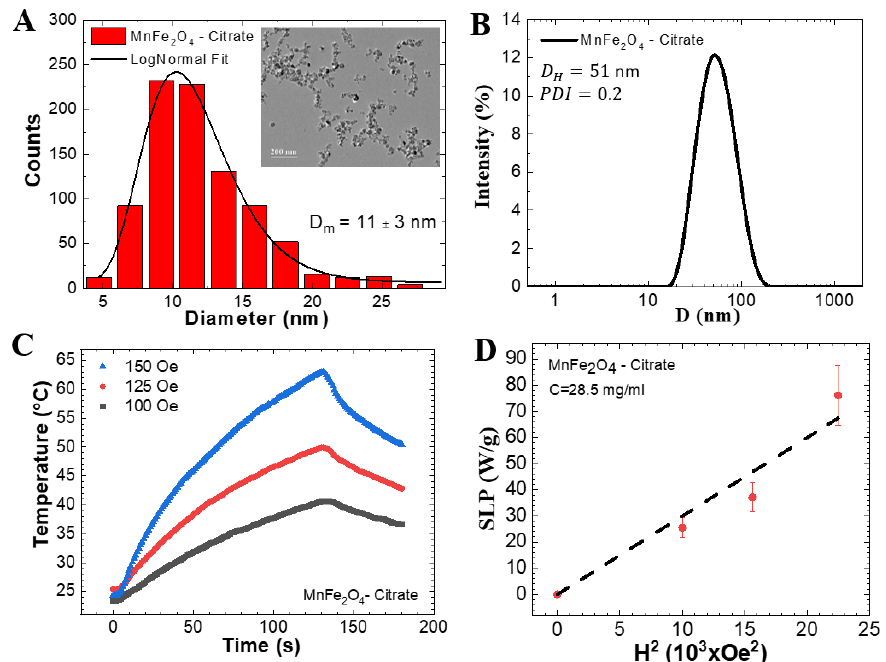
Figure 2. ( A ) Particle size distribution obtained from analysis of TEM pictures. Inset shows a representative TEM picture. ( B ) Dynamic light scattering data of the Mn-ferrite based colloid. ( C ) In vitro MNH temperature profile of a magnetic sample in three magnetic field amplitudes for a frequency of 333 kHz. ( D ) Specific loss power (SLP) as function of the square of the magnetic field. Data obtained using a particle concentration of 28.5 mg/mL.